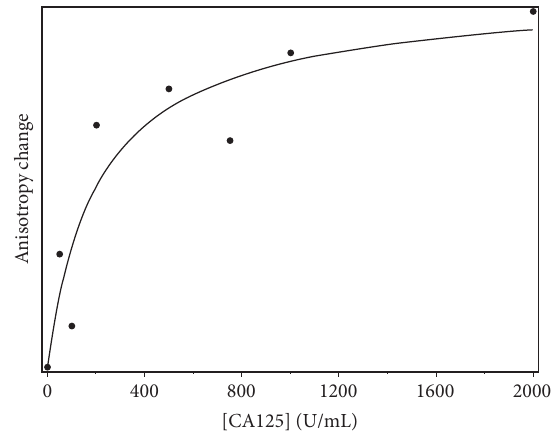
Figure 5: Binding isotherm determined from fluorescence ani- sotropy of samples containing 100 nM Texas Red-labeled aptamer CA125 1 and varying concentrations of CA125. Fluorescence was excited with polarized light at 585 nm; emission at 635 nm was collected along optical paths parallel and perpendicular to the excitation light and used to calculate anisotropy.